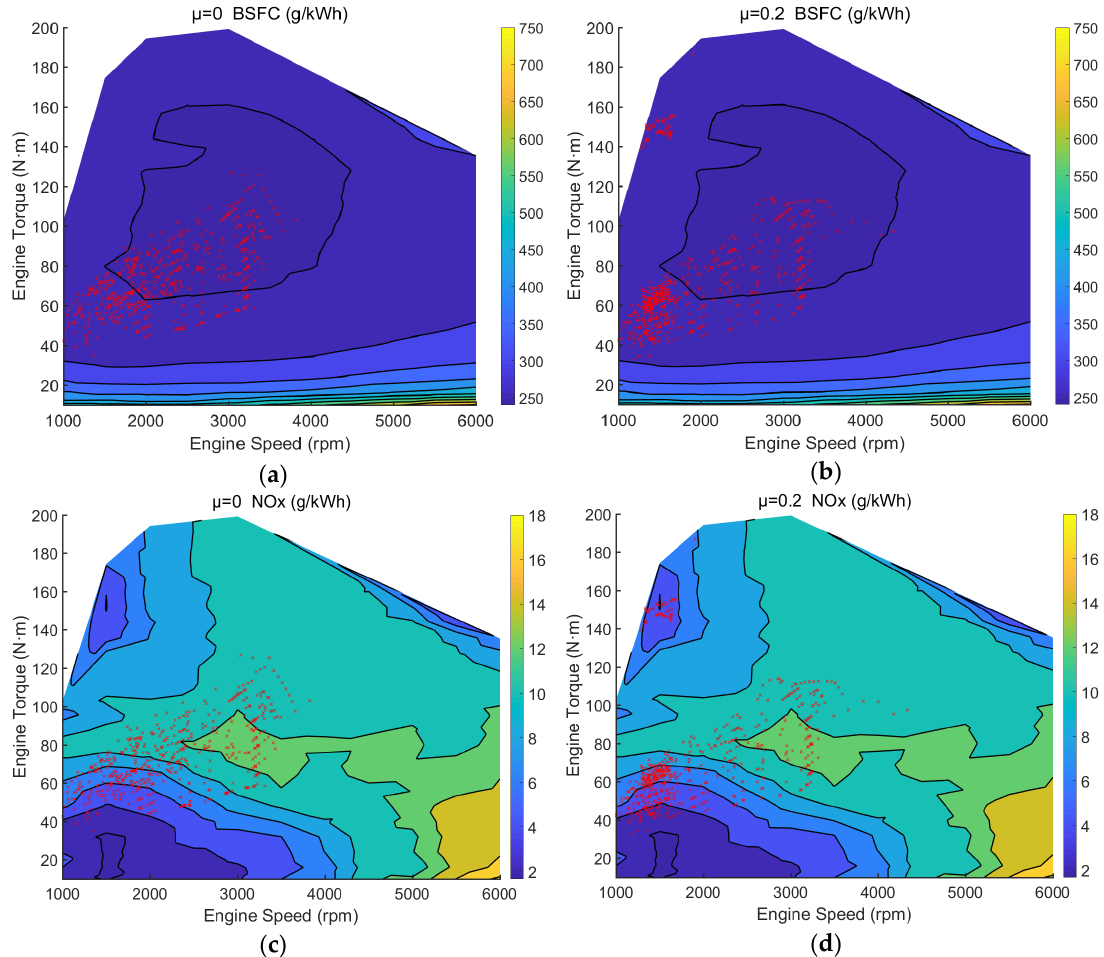
Figure A1. Comparison results of different weighting coefficients for emission NOx. ( a ) 𝜇 = 0 BSFC; ( b ) 𝜇 = 0.2 BSFC; ( c ) 𝜇 = 0 NOx; ( d ) 𝜇 = 0.2 NOx.